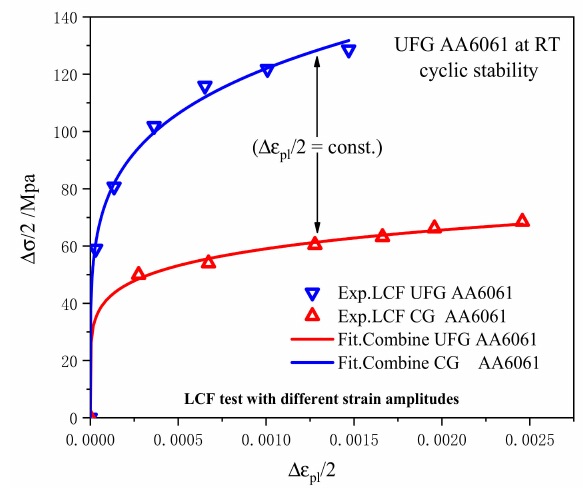
Figure 8. Stress amplitude vs. plastic strain amplitude